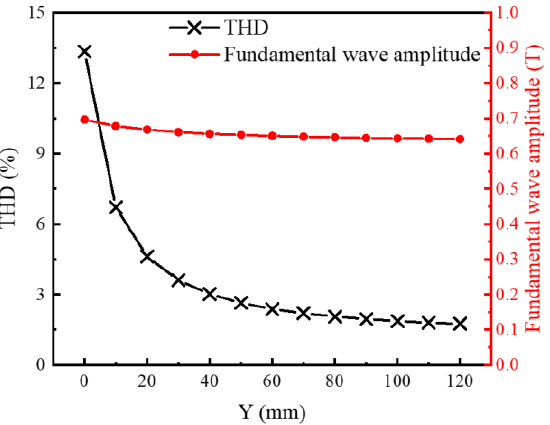
Figure 5. ( a ) Schematic diagram of eccentric magnetizing fixture. ( b ) Magnetization simulation cloud chart.